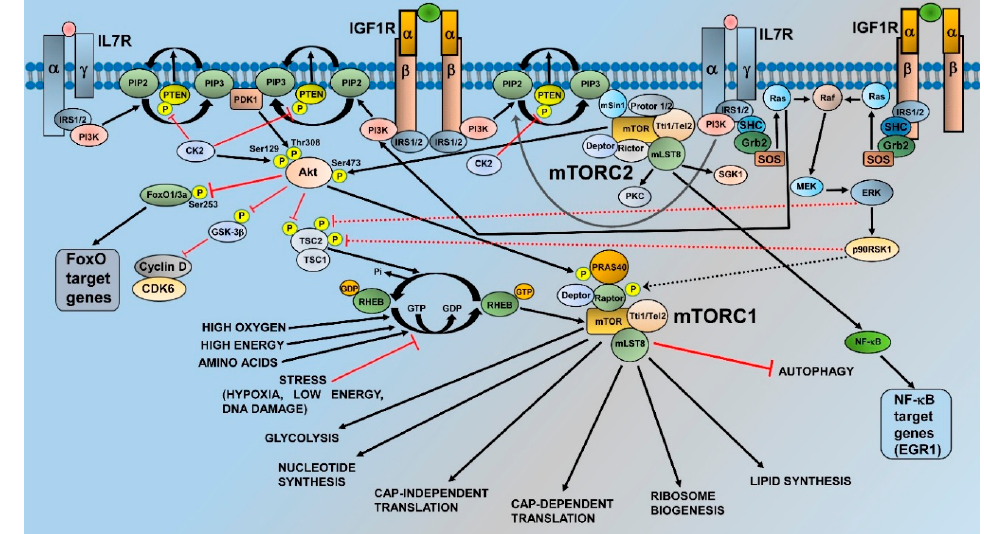
Figure 1. Regulation and functions of mechanistic target of rapamycin complex 1 (mTORC1) and mTORC2. For details, see the text. Black arrows indicate stimulatory events, while red lines indicate inhibitory events.